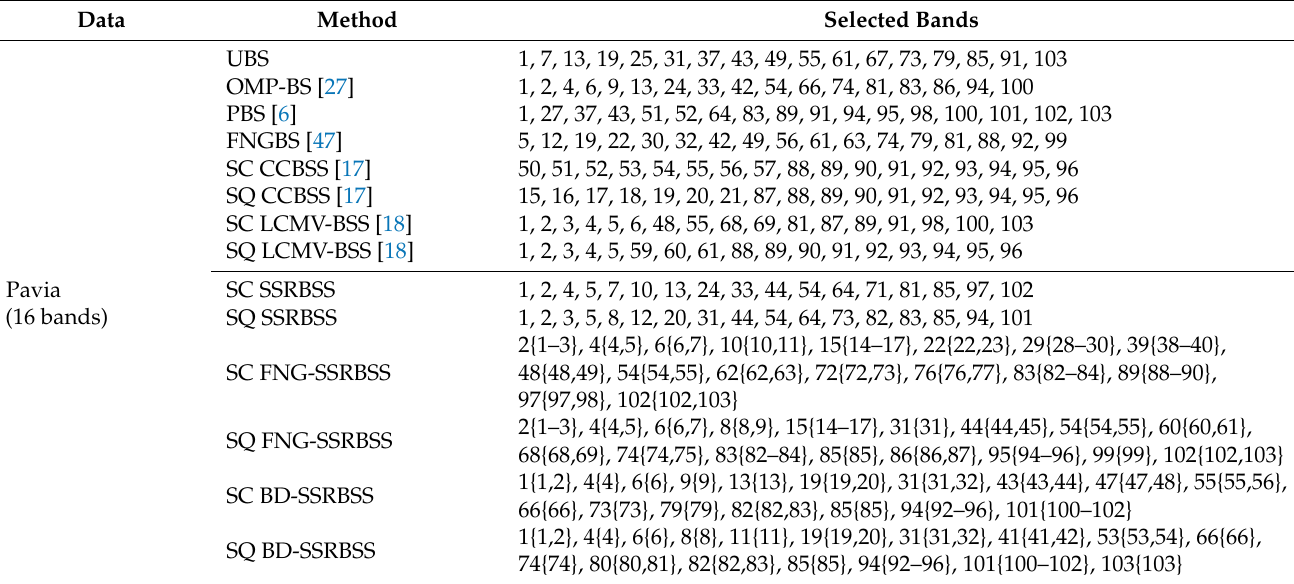
Table 3. The bands selected by the proposed and the compared methods for the Pavia dataset.